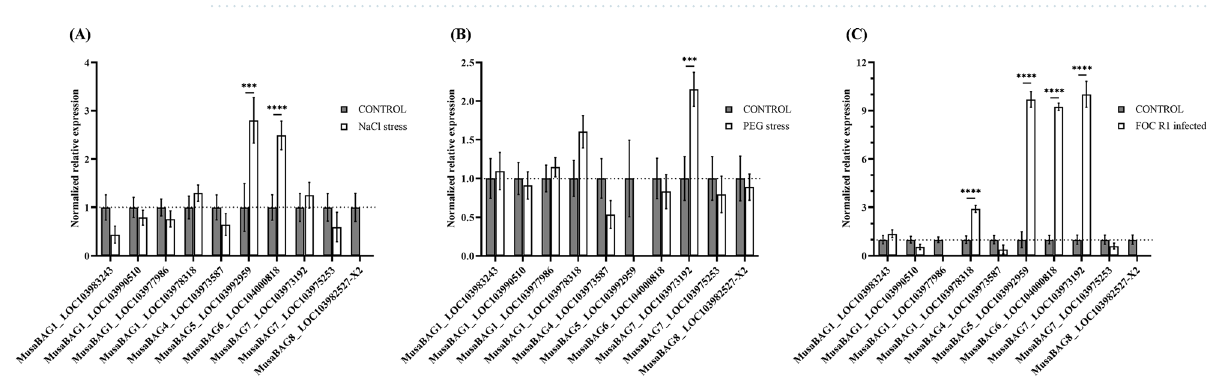
Figure 7. Relative expression profile of MusaBAG genes in biotic and abiotic stress condition using quantitative RT-PCR analysis. ( A ) The expression levels of MusaBAG genes under sodium chloride stress condition (depicted as white bars) showed significant difference for MusaBAG5 as well as MusaBAG6 at P < 0.001 and P < 0.0001 respectively, as compared to the unstressed control plants (depicted as grey bars). ( B ) The expression levels of MusaBAG genes under PEG stress condition (depicted as white bars) showed significant difference only for MusaBAG7 _LOC103973192 at P < 0.001, as compared to the unstressed control plants (depicted as grey bars). ( C ) Expression levels of MusaBAG genes inoculated with Fusarium oxysporum f. sp. cubense race 1 (Foc R1) depicted in white bars with respect to the uninfected control (depicted as grey bars) showed